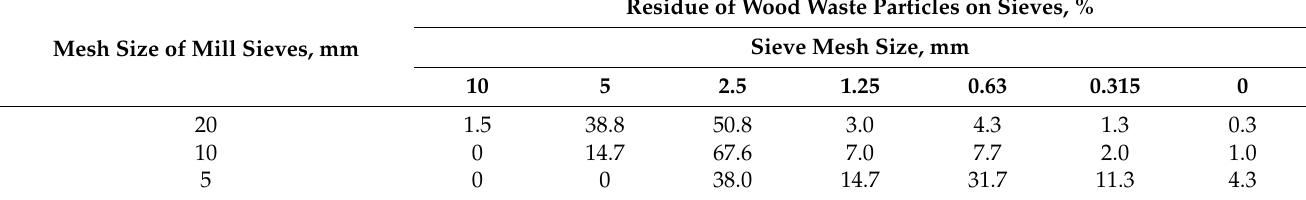
Table 2. Description of the wood waste particles after milling. Residue of Wood Waste Particles on Sieves, % Sieve Mesh Size, Mesh Size of Mill Sieves, mm